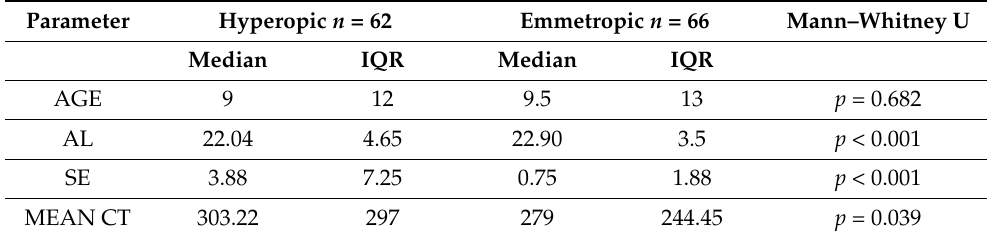
Table 1. Baseline characteristics of study